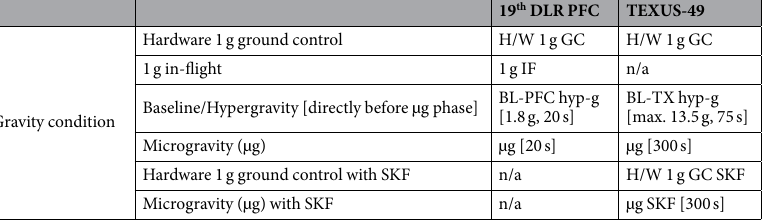
Table 1. Nomenclature of experiment groups of the 19 th DLR parabolic flight and TEXUS-49 suborbital ballistic rocket campaigns. Additional information on the group is given in squared brackets. SKF: SKF-96365, n/a: not